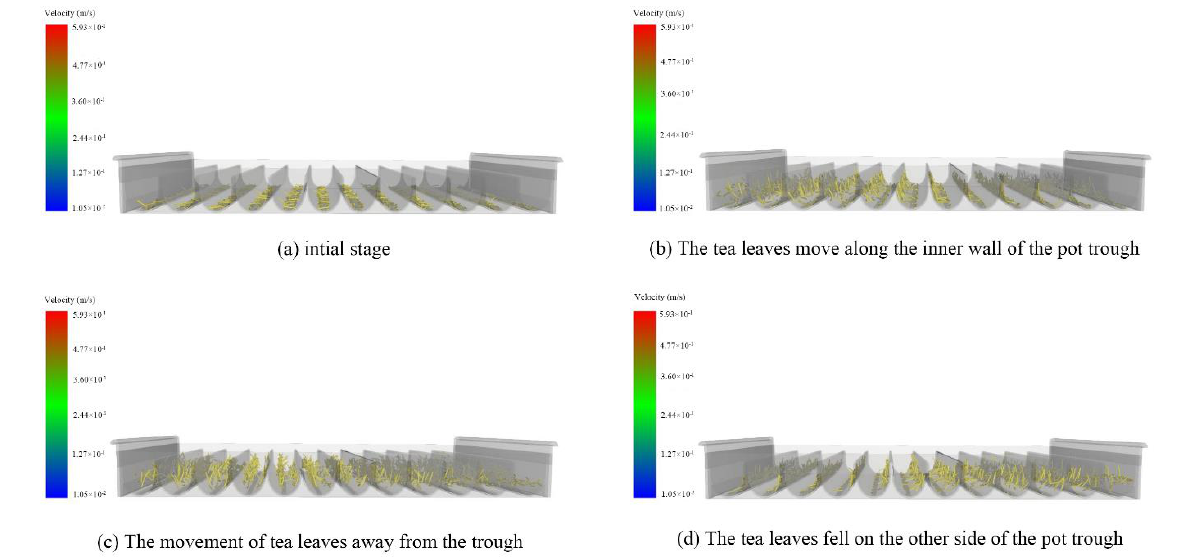
Figure 9. Simulation model of de-enzyming and carding machine in EDEM.